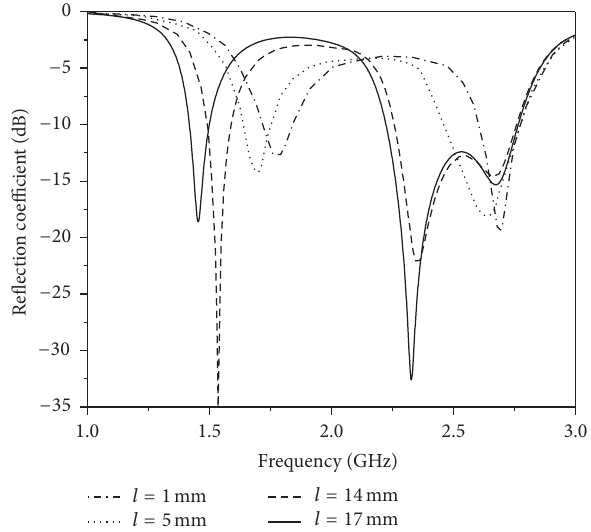
Figure 6: Simulated reflection coefficient for different slot lengths.